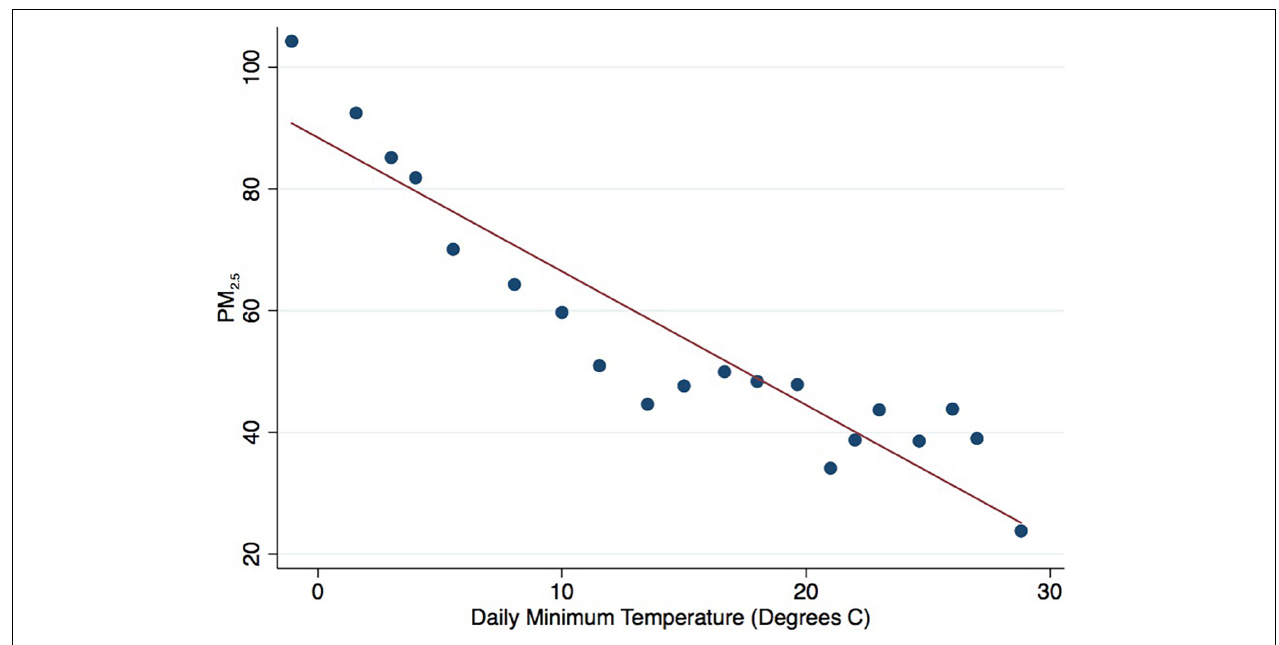
FIGURE 2 | Binned scatter relationship between PM 2 . 5 and daily minimum temperature.